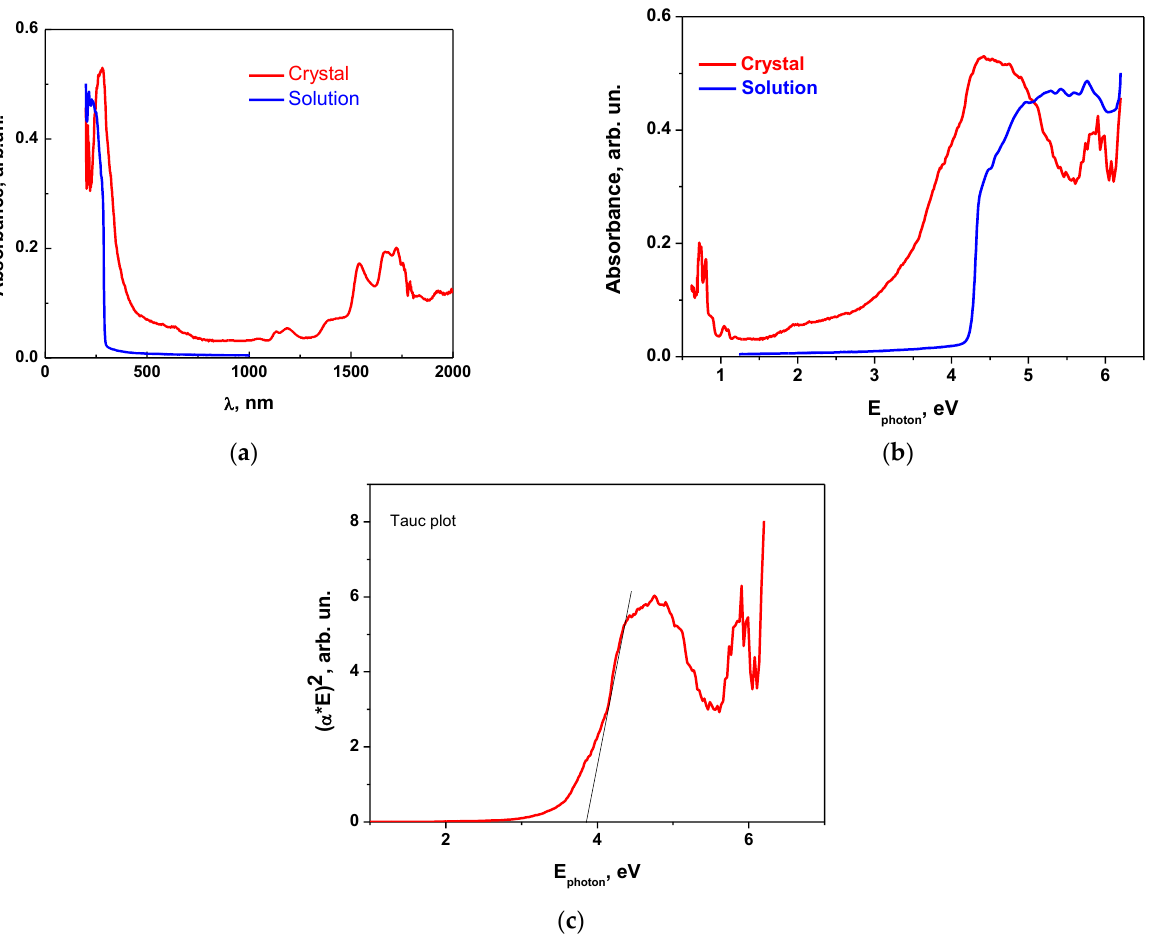
Figure 8. Absorbance spectra of MBI · HClO 4 single crystal (Sample 1) and aqueous solution of MBI · HClO 4 crystals ( a , b ). Tauc plot for direct allowed electronic transitions in MBI · HClO 4 crystal (Sample 1) ( c ).